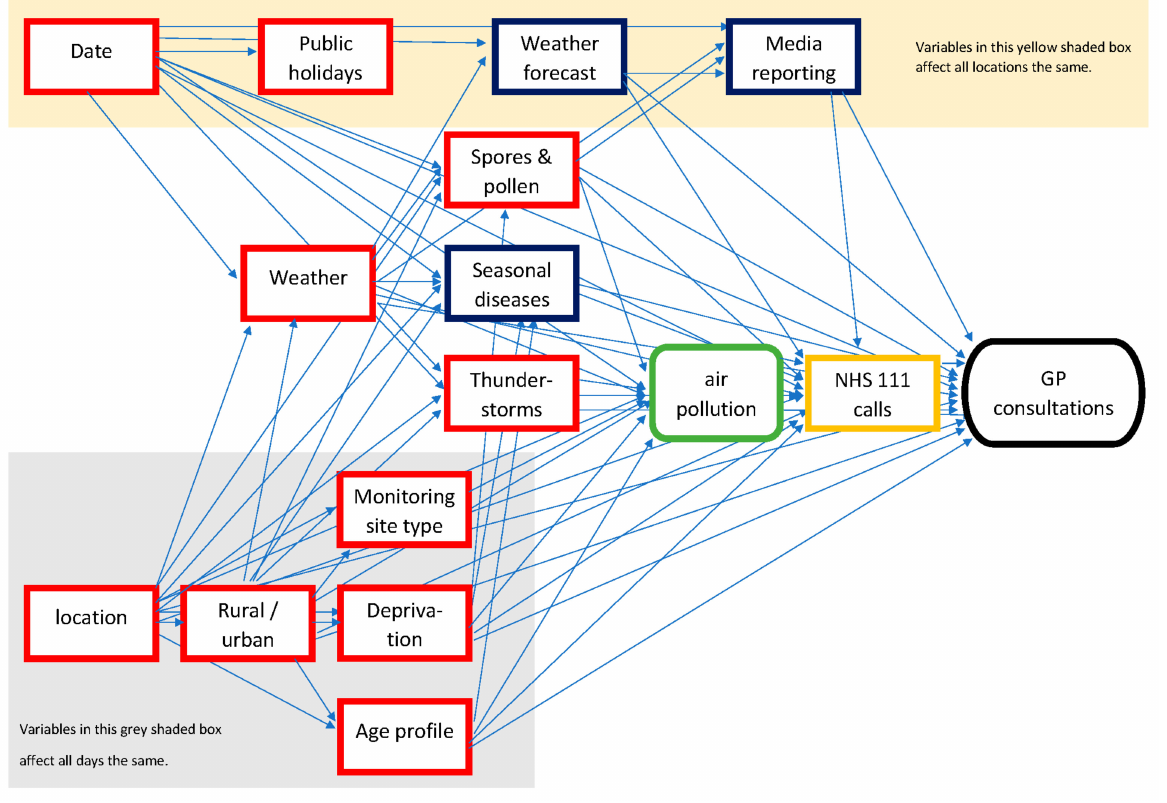
Figure 1. DAG to investigate impact of air pollution on GP consultations. Red boxes depict confound- ing variables that affect both the exposure of air pollution and the outcome, GP consultations. Blue boxes show variables that are competing exposures, affecting GP consultations but not